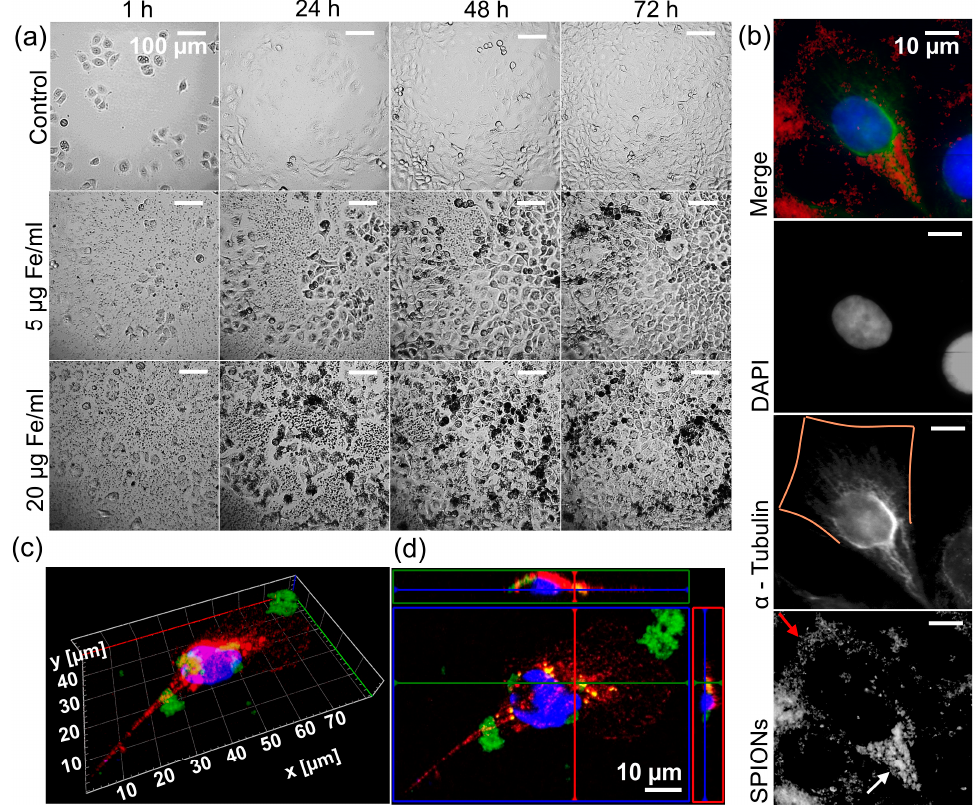
Figure 3. Intake of the SPIONs by the tumor cells. ( a ) Representative images of Cal33 cells, an HPV-negative (HPV-) head and neck squamous cell carcinoma (HNSCC) cell line, with different concentrations of nanoparticles (0, 5, and 20 µg Fe/mL) over time (1, 24, 48, and 72 h). For the full course of the interaction and depiction of 50 µg Fe/mL, see the video in Supplementary Material. ( b ) Immunofluorescence images of a cell from an HPV- HNSCC cell line RPMI 2650. Top to bottom: merge with DAPI (blue), α -Tubulin (green), nanoparticles (red); greyscale images of DAPI, α -Tubulin with orange line as estimated outline of the cell, nanoparticles captured with transmitted light microscope with red arrow on nanoparticles on cell margin, and white arrow on nanoparticles inside cell. ( c ) Three-dimensional immunofluorescence imaging of an RPMI 2650 cell with FITC-linked SPIONs (green), α -Tubulin (red), and DAPI (blue). ( d ) Orthogonal imaging of an RPMI 2650 cell with FITC-linked SPIONs (green), α -Tubulin (red), and DAPI (blue).